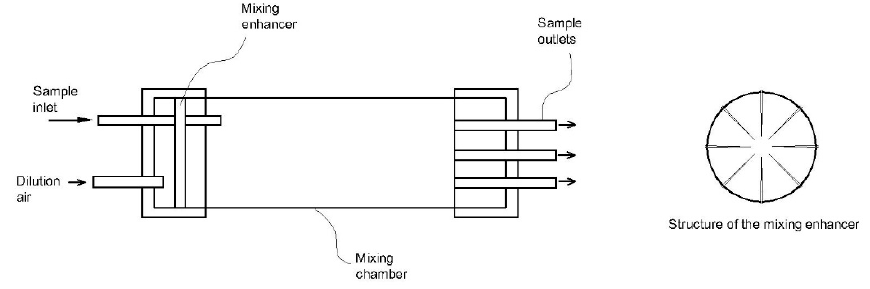
Figure 10. A compact dilution system invented by Lipsky and Robinson [111].